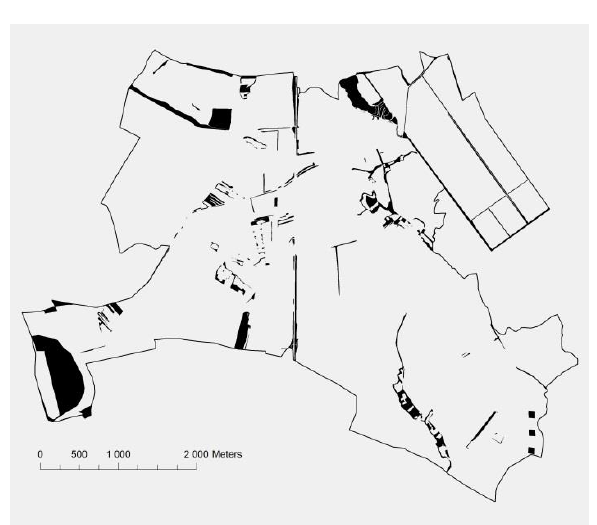
Figure 6. Green areas, which have disappeared